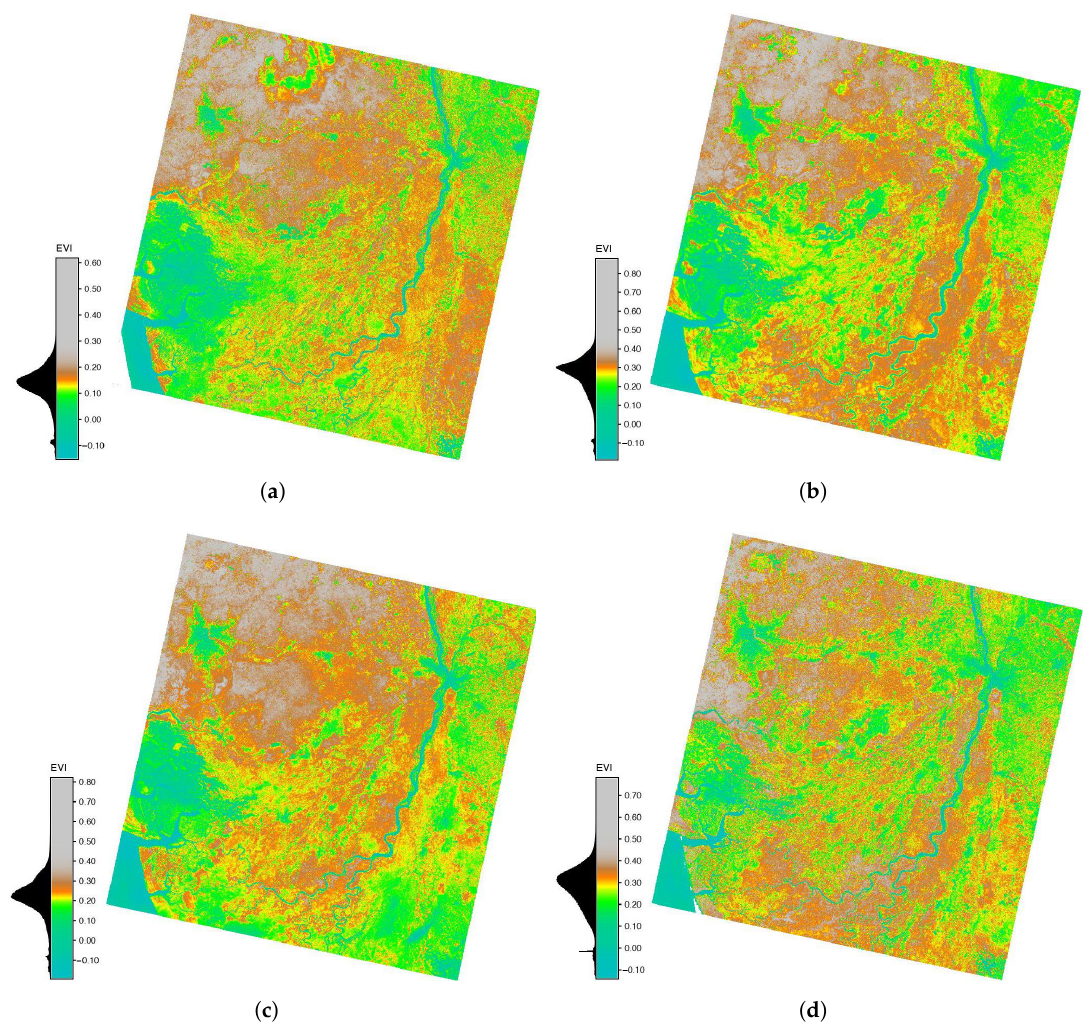
Figure 12. EVI computed from the Landsat 8-9 OLI/TIRS images of Niger River Delta for four years: ( a ) 2013, ( b ) 2015 ( c ) 2021, ( d )